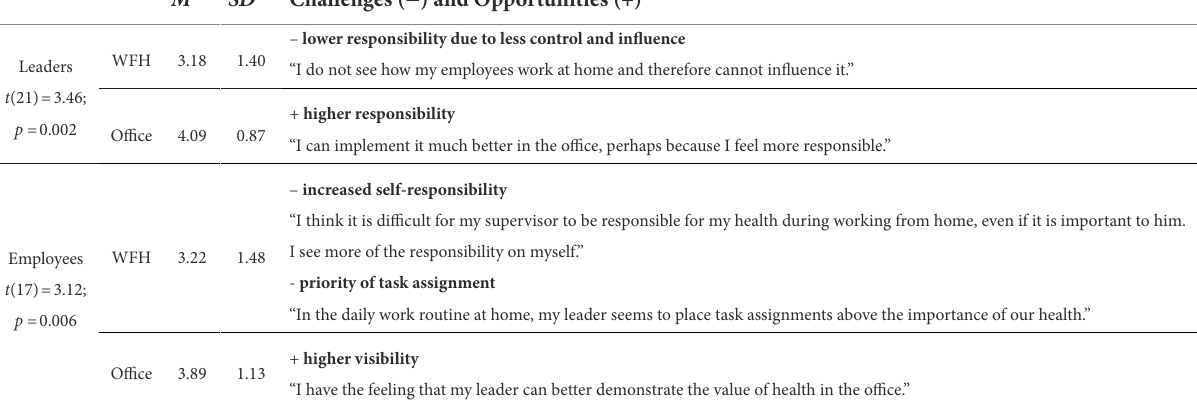
TABLE 5 Challenges and opportunities for Value – HoL. M SD Challenges ( − ) and Opportunities